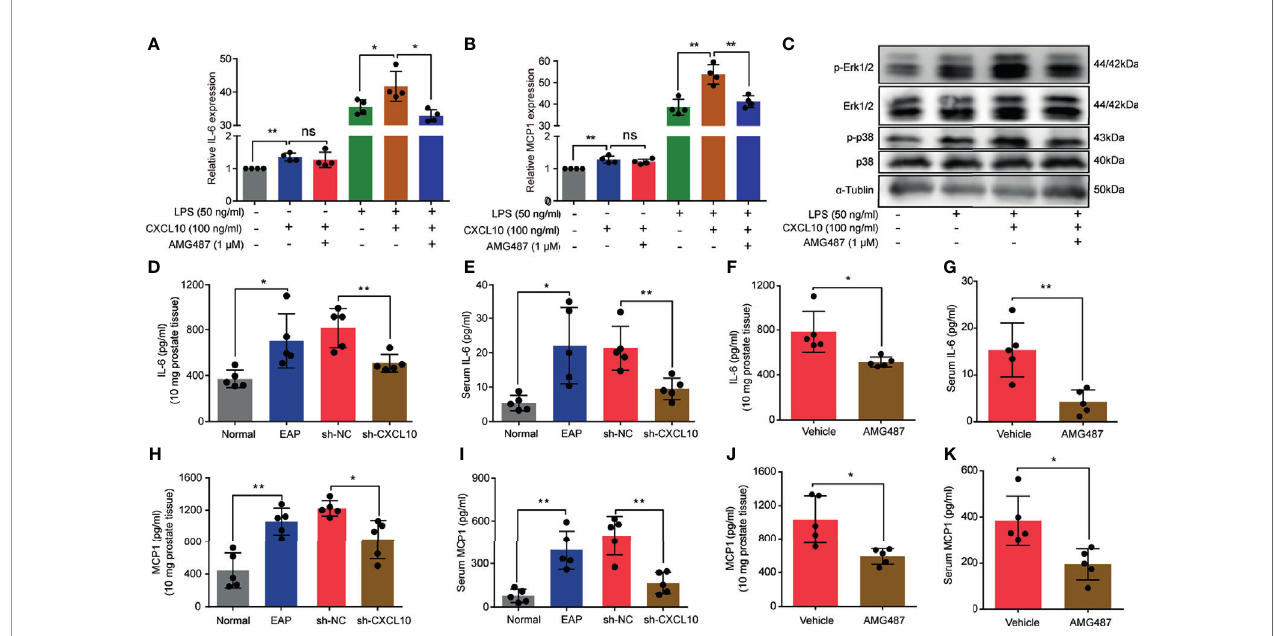
FIGURE 7 | CXCL10 promotes secretions of in fl ammatory mediators of macrophage via CXCR3-mediated ERK and p38 MAPK activation. The mRNA expression levels of IL-6 (A) and MCP1 (B) in BMDMs were calculated 3 h after LPS treatment. BMDMs from EAP mice were pretreated with AMG487 (1 m M) for 1 h, then stimulated with CXCL10 (100 ng/ml) for 12 h, and then with LPS (50 ng/ml) for 3 h. Cells were collected for detecting the mRNA expression levels of IL-6 (A) and MCP1 (B) . (C) Western blot analysis of the phosphorylation of the ERK1/2, and p38 MAPK signaling pathways in LPS-induced macrophages for 3 h. The expression levels of IL-6 in the prostate (D) and serum (E) for mice in the normal, EAP, sh-NC, and sh-CXCL10 groups. The expression levels of IL-6 in the prostate (F) and serum (G) for mice in the AMG487 and vehicle groups. The expression levels of MCP1 in the prostate (H) and serum (I) for mice in the normal, EAP, sh-NC, and sh-CXCL10 groups. The expression levels of MCP1 in the prostate (J) and serum (K) for mice in the AMG487 and vehicle groups. Data are shown as mean ± SD by one-way ANOVA analysis (A, B) or unpaired, two-tailed Student ’ s t -test analysis (D – K) . * P < 0.05; ** P < 0.01. ns, no signi fi